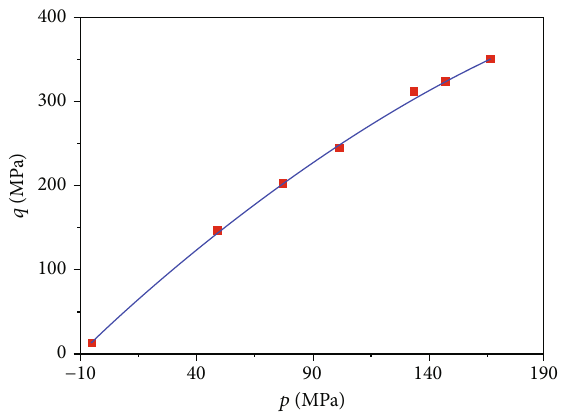
Figure 13: Fitting of the yield surface in the p ~ q Table 3: Parameters de fi ning yield surface in p ~ q plane.